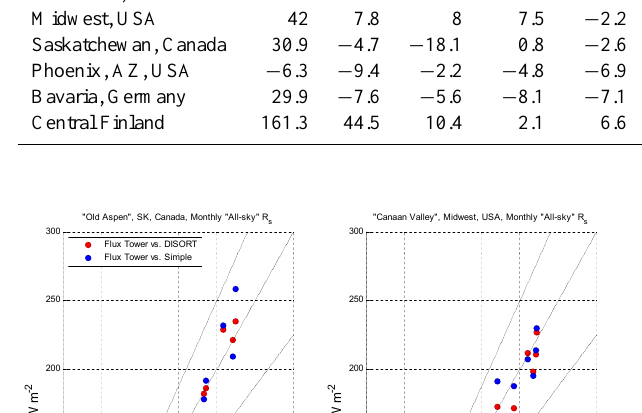
where the slope estimator k 1 is analogous to the T a term of Eq. (2), k 0 is the intercept estimator, and ε i denotes the i th residual, or error. Minimizing the sum of squared residu- als results in an estimator of 0.857 for k 1 , with the sum of squared error (SSE) and coefficient of determination ( R 2 ) equal to the original model. In other words, use of the global mean upwelling transmittance factor 0.854 in the Simple model appears robust and its replacement with 0.857 not jus-